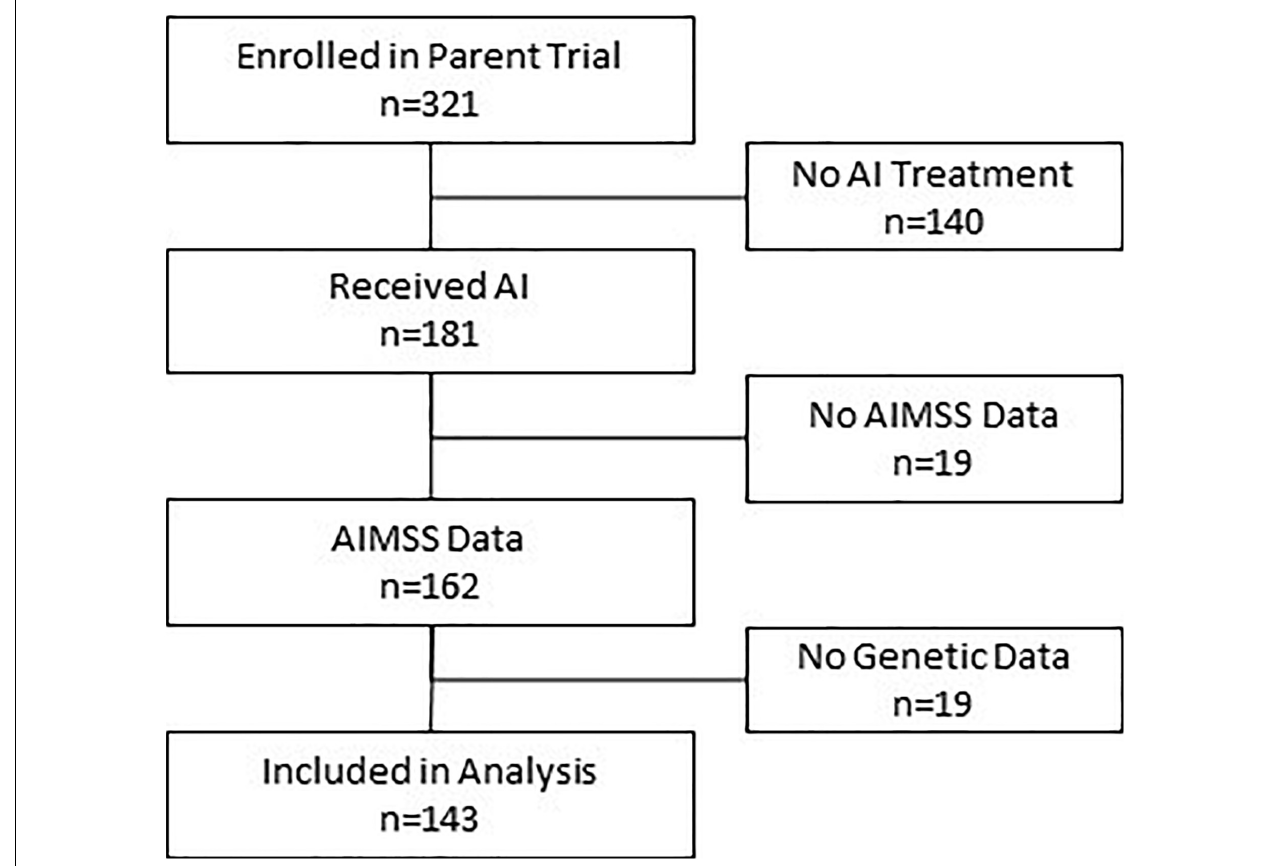
FIGURE 1 | Consort diagram describing patient flow into study and analysis. Of the 321 patients enrolled in the observational clinical study, 143 had all required data and were included in this